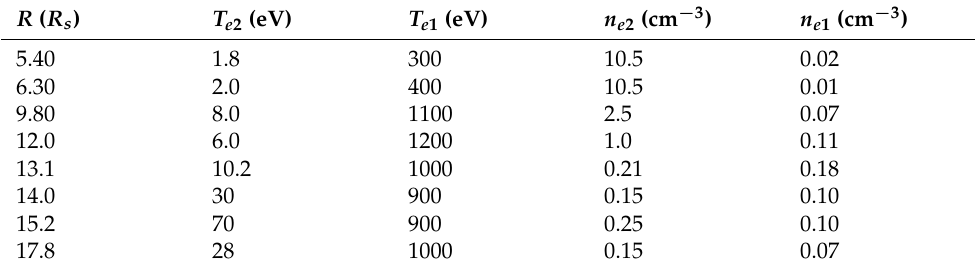
Table 1. Parameter values derived from Schippers et al. corresponding to Saturn’s magnetosphere.